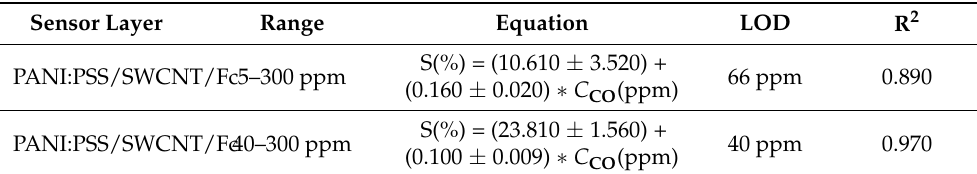
Table 6. Analytical parameters from calibration